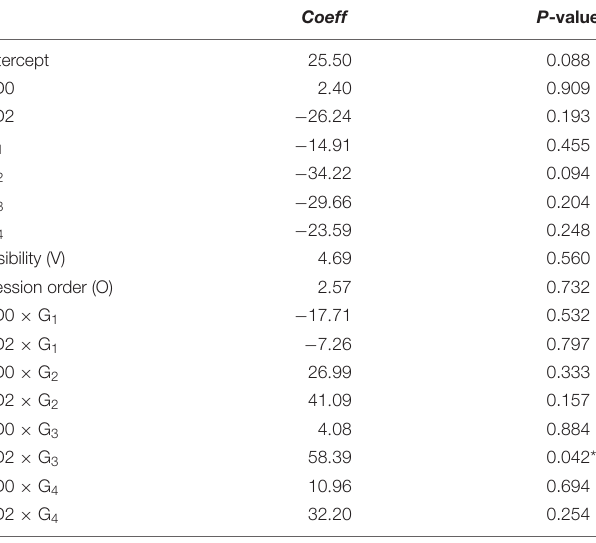
TABLE 7 | Hand motion duration.